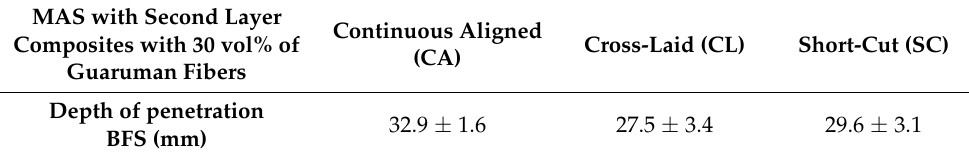
Table 2. BFS from ballistic tests in MASs with second layer of 30 vol% guaruman fibers epoxy